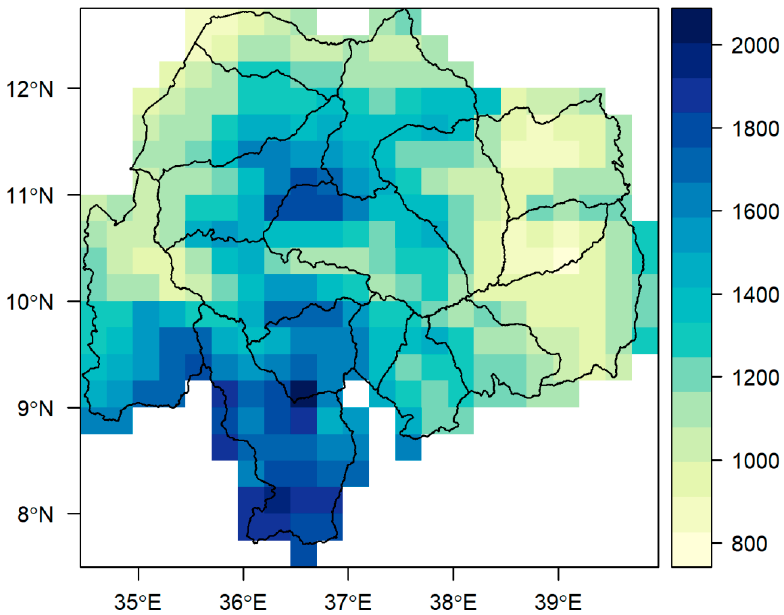
Figure 7. The spatial distribution of mean annual rainfall (mm) over the Upper Blue Nile Basin (UBNB) in Ethiopia (1992 to 2017).